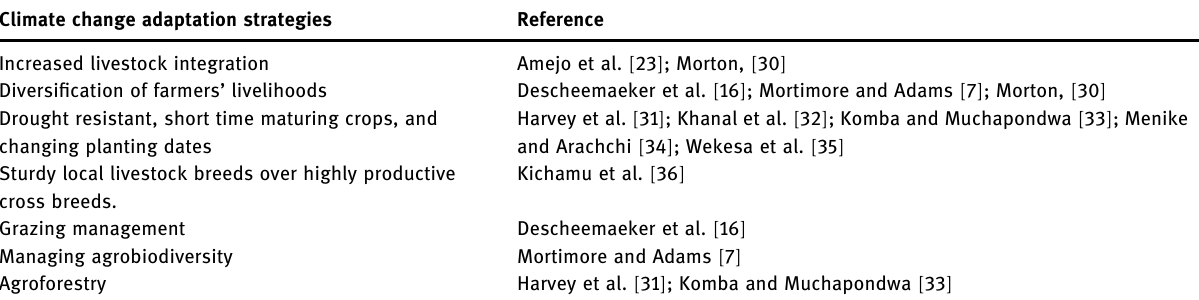
Table 5: E ff ective climate change adaptive strategies for smallholder farms Climate change adaptation